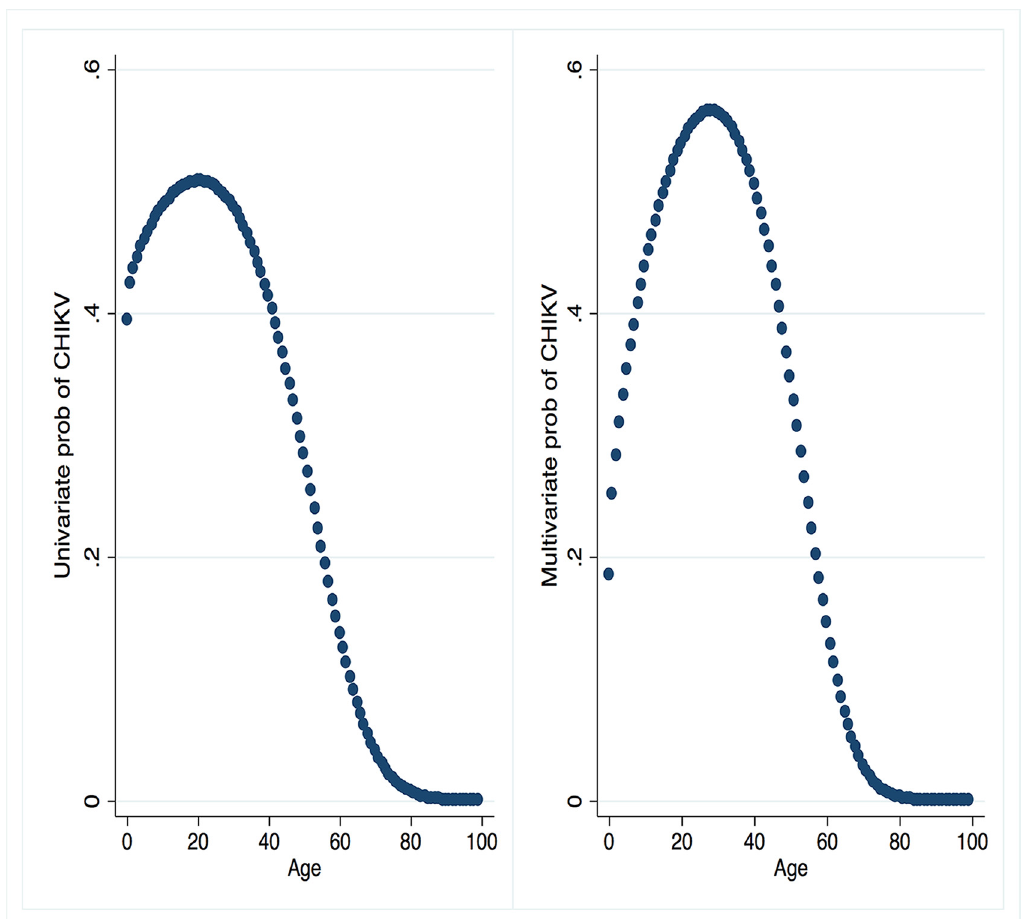
Fig 1. Association curve between age and risk of CHIKV infection in univariate analysis and after multivariate analysis, using random effects logistic regression to account for correlation within households, Trapeang Roka, Cambodia, 2012.